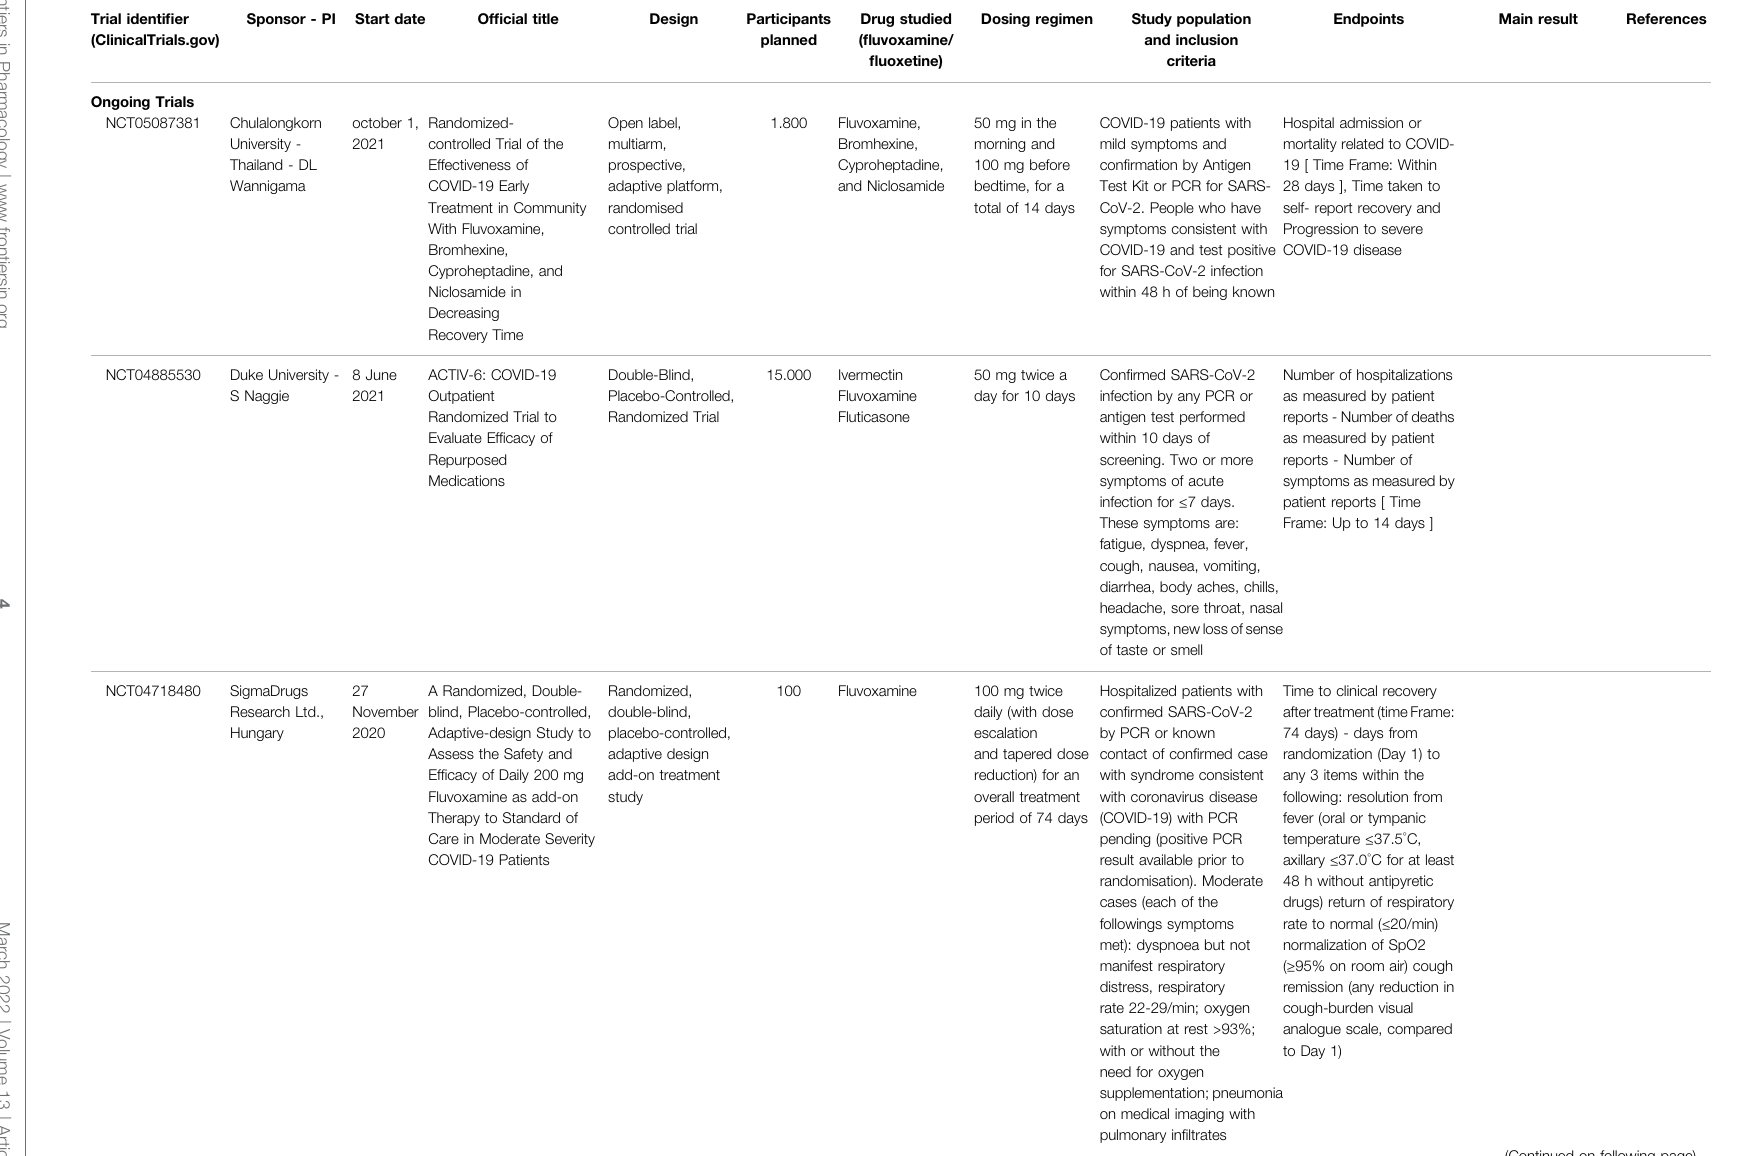
TABLE 1 | ( Continued ) Main features of completed, ongoing, suspended and withdrawn trial on fl uvoxamine and fl uoxetine in patients with